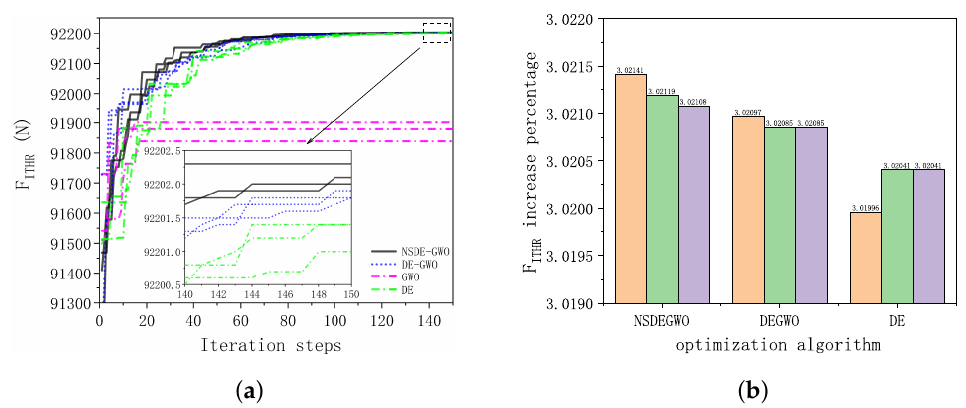
Figure 5. ( a ) Optimization effect of maximum installed thrust control of four intelligent algorithms (DE, GWO, DE-GWO, and NSDE-GWO). ( b ) Histogram of installed thrust-increase percentage.